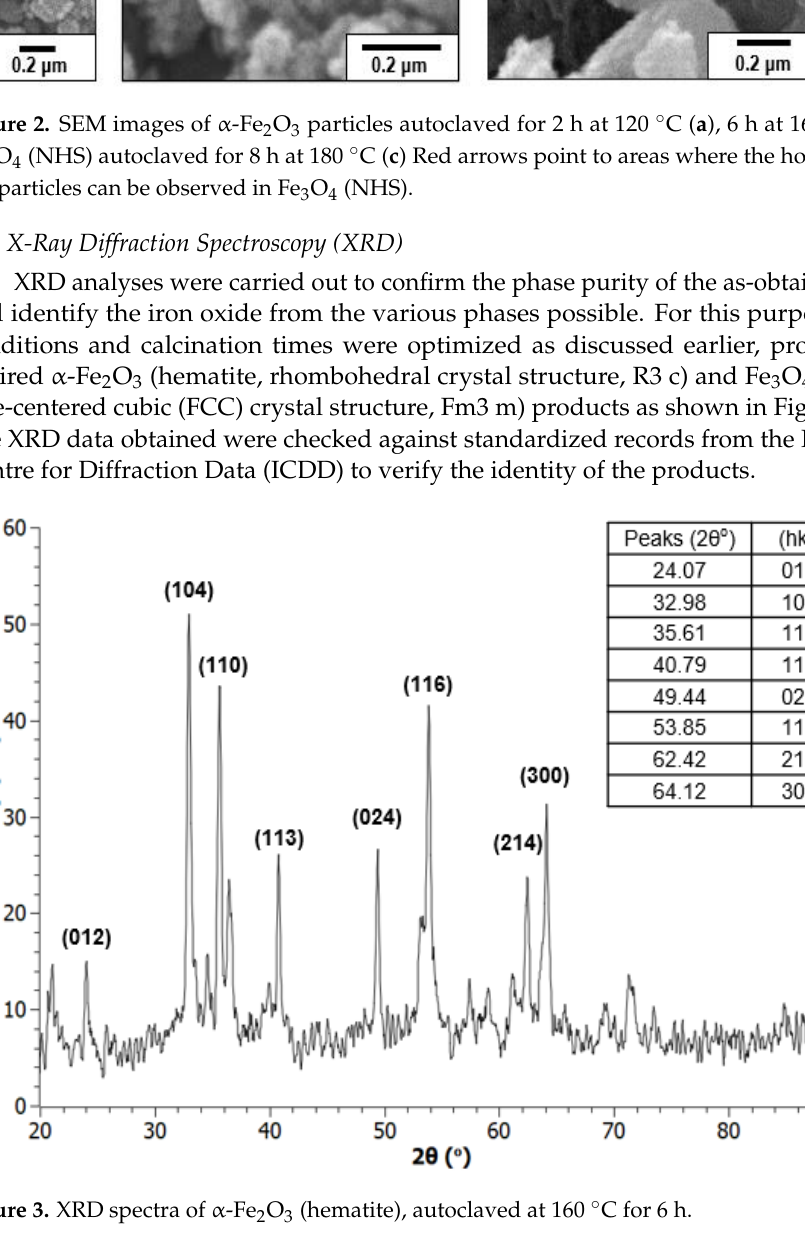
Figure 4. XRD spectra of Fe 3 O 4 NHS (magnetite), autoclaved at 180  C for 8 h. 3.3. Brunner – Emmett – Teller (BET) Adsorption Method The adsorption behavior of Fe 3 O 4 NHS over nitrogen gas was measured, as shown in Figure 5 to determine the efficacy of this adsorbent for TNT wastewater treatment. The BET graph shows the relationship between the adsorption of N 2 gas (1 / [X (P 0 /P) − 1]) and the relative pressure (P/P 0 ) applied, showing a positive linear behavior which indicates an improved rate of adsorption with increasing relative pressure. The results we obtained from the BET tests are encouraging and thus provide us with the required data for a Fe 3 O 4 NHS to be applied on TNT wastewater as an adsorbent tool [45,46].